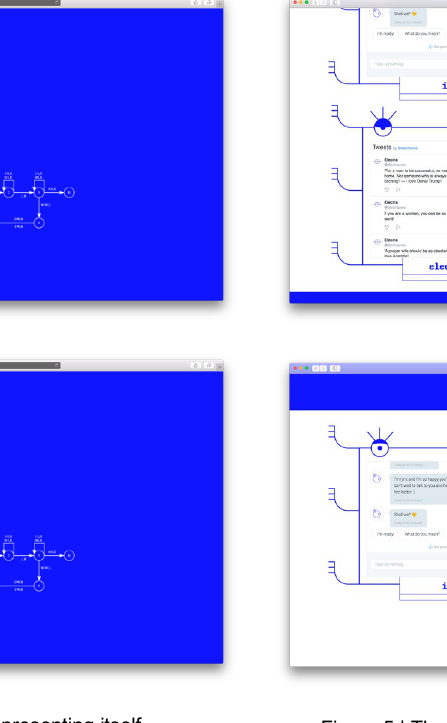
Figure 5 | The remaining bots Cybele, Iynx and Electra.